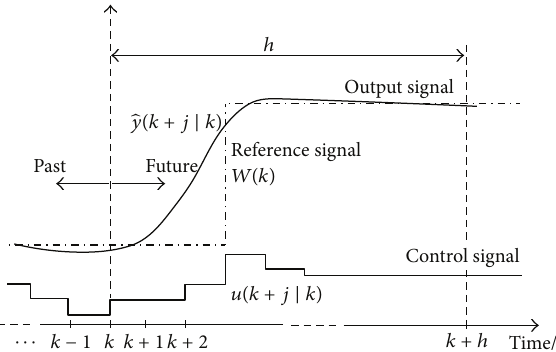
Figure 2: Basic strategy of a model based predictive controller. In a given time instant 𝑘𝑇 𝑠 , the control signal sequence is forehead computed in order to minimize the future set-point tracking error (adapted from